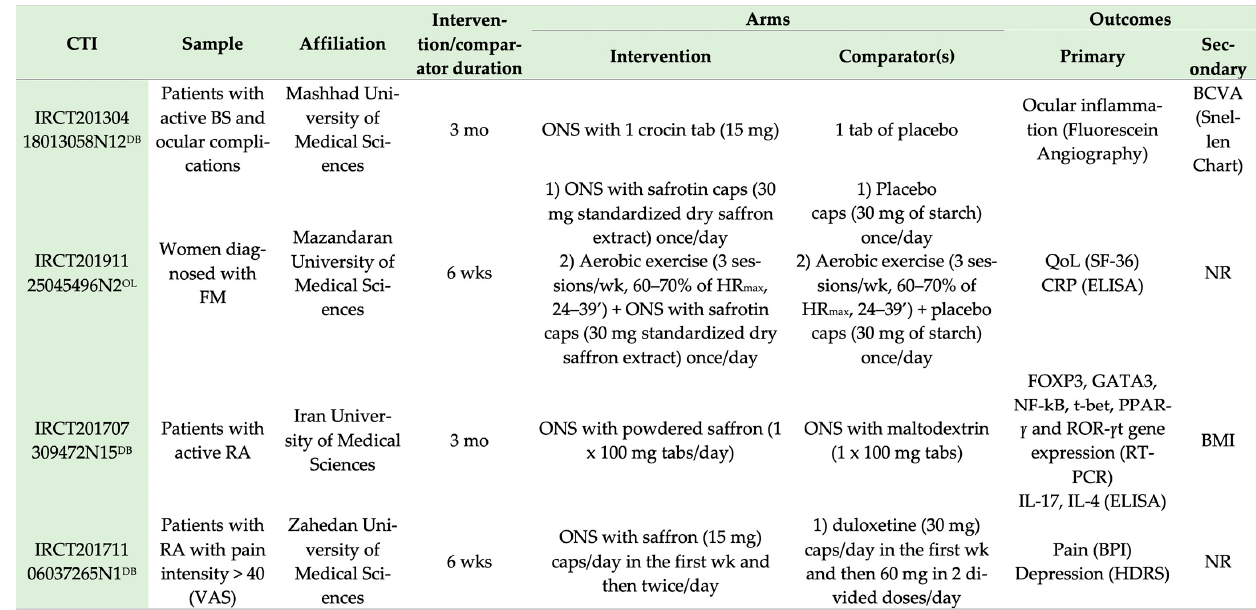
Figure 7. Parallel RCTs investigating ONS with saffron in patients with rheumatic diseases. BCVA, best corrected visual acuity; BMI, body mass index; BPI, brief pain inventory; BS, Behcet’s syndrome; CRP, C-reactive-protein; CTI, clinical trial identifier; ELISA, enzyme-linked immunosorbent assay; FM, fibromyalgia; FOXP3, forkhead box P3; HDRS, Hamilton Depression Survey Questionnaire; HR max , maximum heart rate; IL-4, interleukin-4; IL-17, interleukin-17; mo, months; NF-kB, nuclear factor kappa-light-chain-enhancer of activated B cells; NR, not reported; ONS, oral nutrient supplementation; PPAR- γ , peroxisome proliferator-activated receptors γ ; QoL, quality of life; RA, rheumatoid arthritis; RCT, randomized controlled trial; ROR- γ t, RAR-related orphan receptors γ t (thymus-specific isoform); RT-PCR, real-time polymerase chain reaction; SF-36, Short Form 36; T-bet, T-Box protein expressed in T cells; VAS, visual analogue scale; wks, weeks; DB double blind; OL open label.